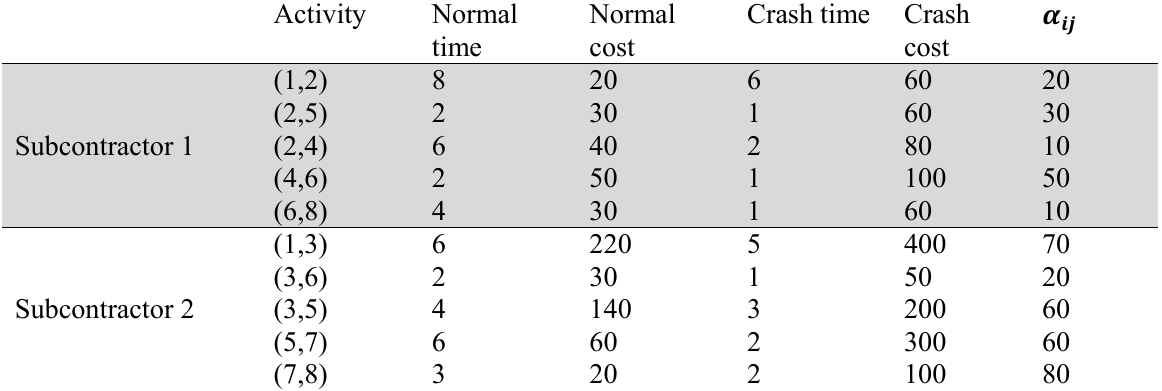
Network information of the illustrative example with three subcontractors Activity Normal